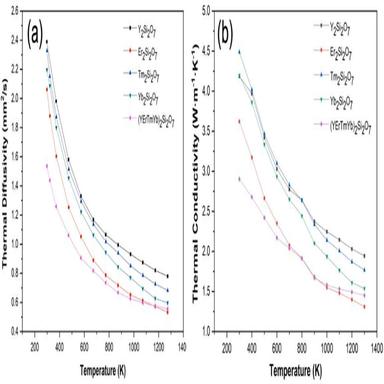
(a) Thermal diffusivity and (b) thermal conductivity of (Y0,25Er0,25Tm0,25Yb0,25)2Si2O7.